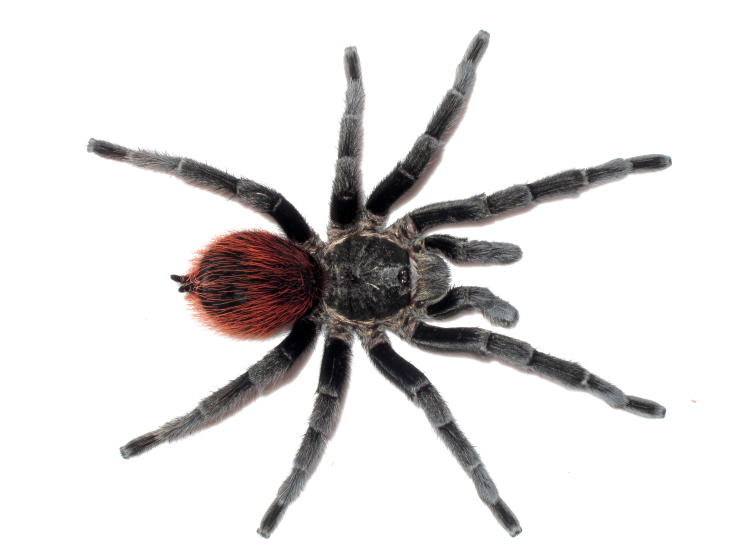
Brachypelma
sabulosum (F. O. P.-Cambridge, 1897) male. Photo: Jorge Mendoza.